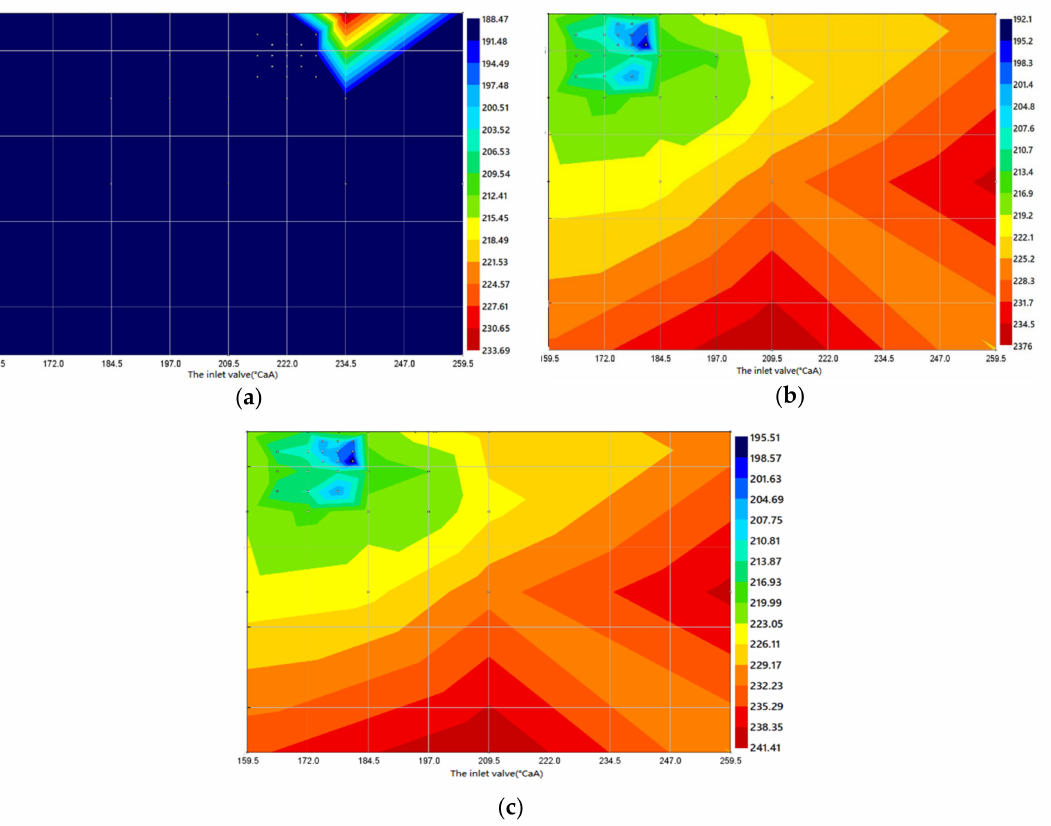
Figure 7. ( a ) B0, ( b ) B10, ( c ) B20. BSFC of different biodiesel ratios under 75% load